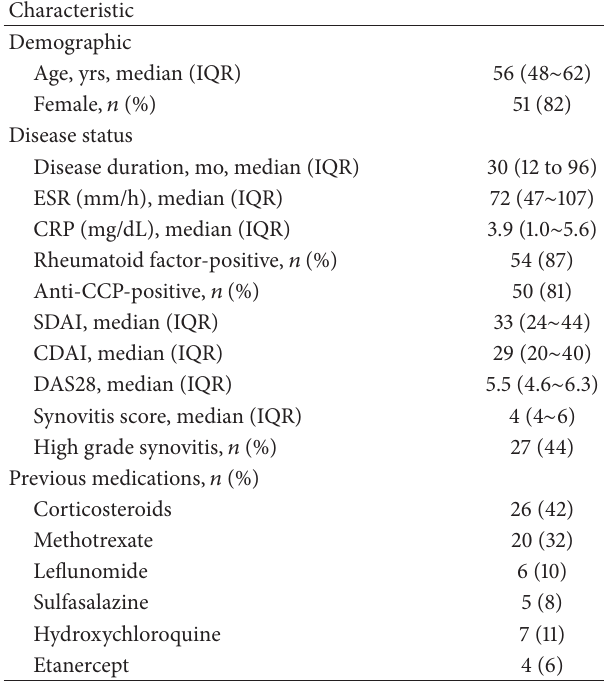
Table 1: Baseline demographic and clinical features of RA